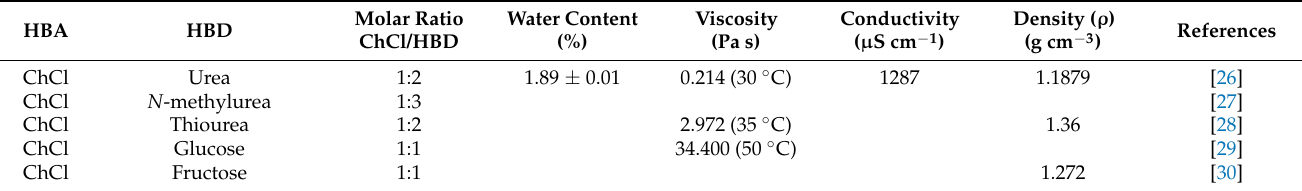
Table 1. Physical parameters of the tested